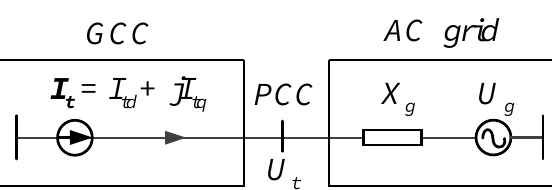
Figure 2. Equivalent AC circuit of GCC connected to the AC grid.